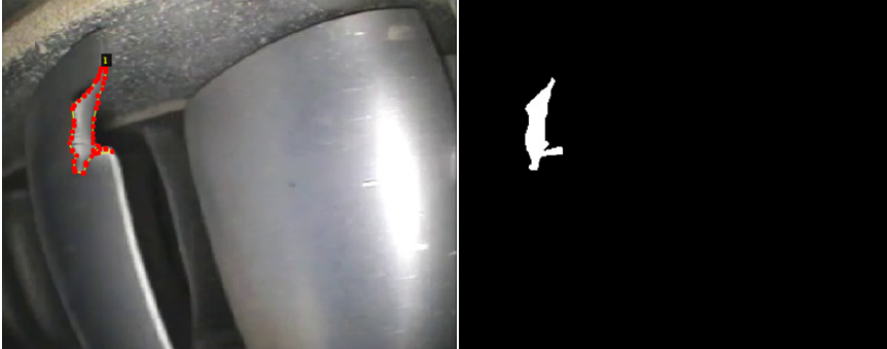
Figure 7. Masks for image